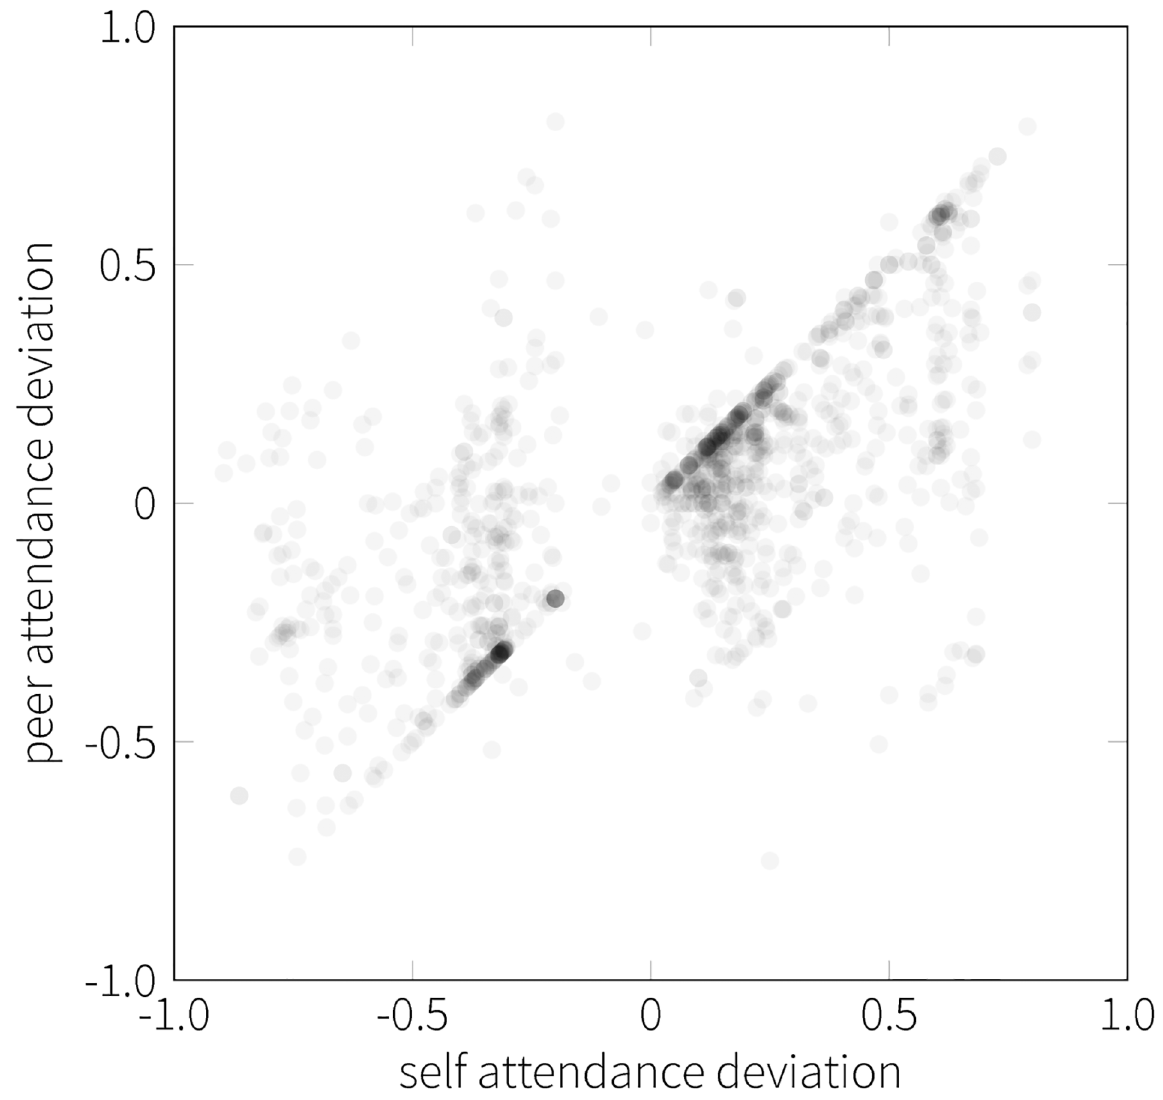
Fig 7. Correlation between self and peer corrected attendance. Shownare the attendance relative to the averagecalculatedat the level of classes. Each dot representsa student’s own and their peers’ median deviationfrom the averageattendance with respect to a course, that is, their attendance deviationaveraged over all classes of a